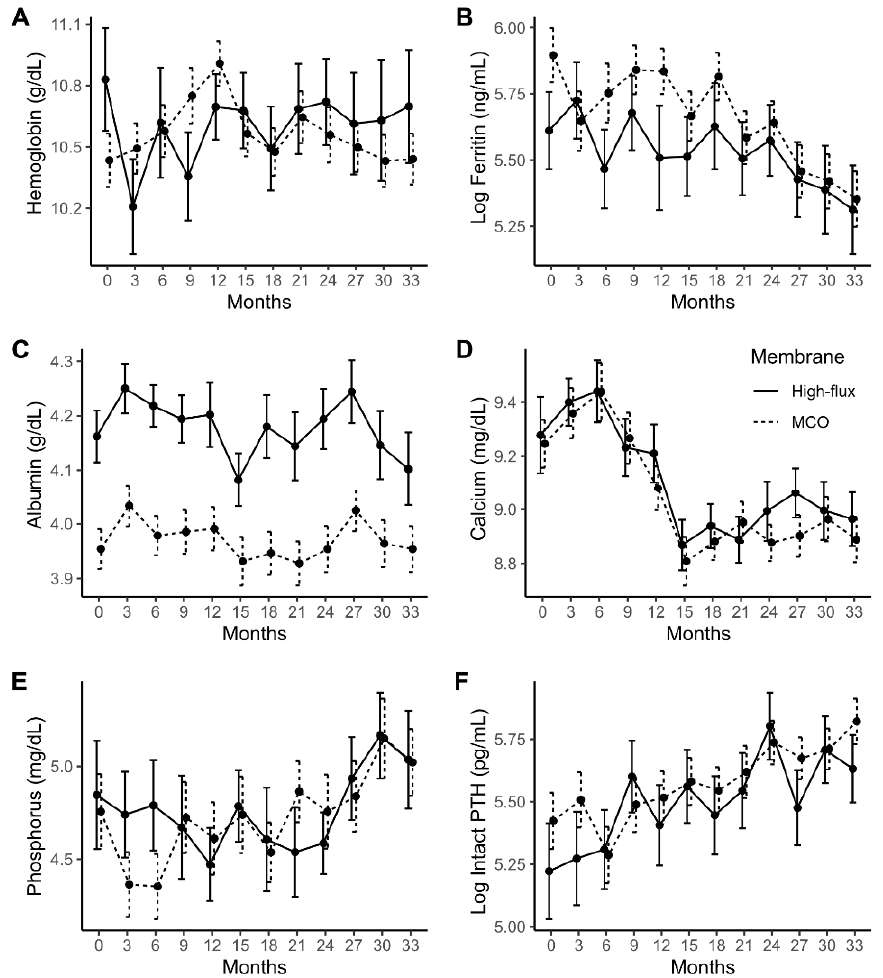
Figure 2. Changes of laboratory findings during the three-year treatment period according to the membrane type. The average values of the laboratory parameters including hemoglobin ( A ), ferritin ( B ), serum albumin ( C ), total calcium ( D ), phosphorus ( E ), and intact PTH ( F ) are shown. Data are presented as arithmetic means (black dots) and standard errors (error bars) as an error bar plot. The values of the high-flux group are represented as solid lines, and those of the MCO group as dash lines. Ferritin and intact PTH values were log transformed. MCO, medium cut-off membrane; PTH, parathyroid hormone.